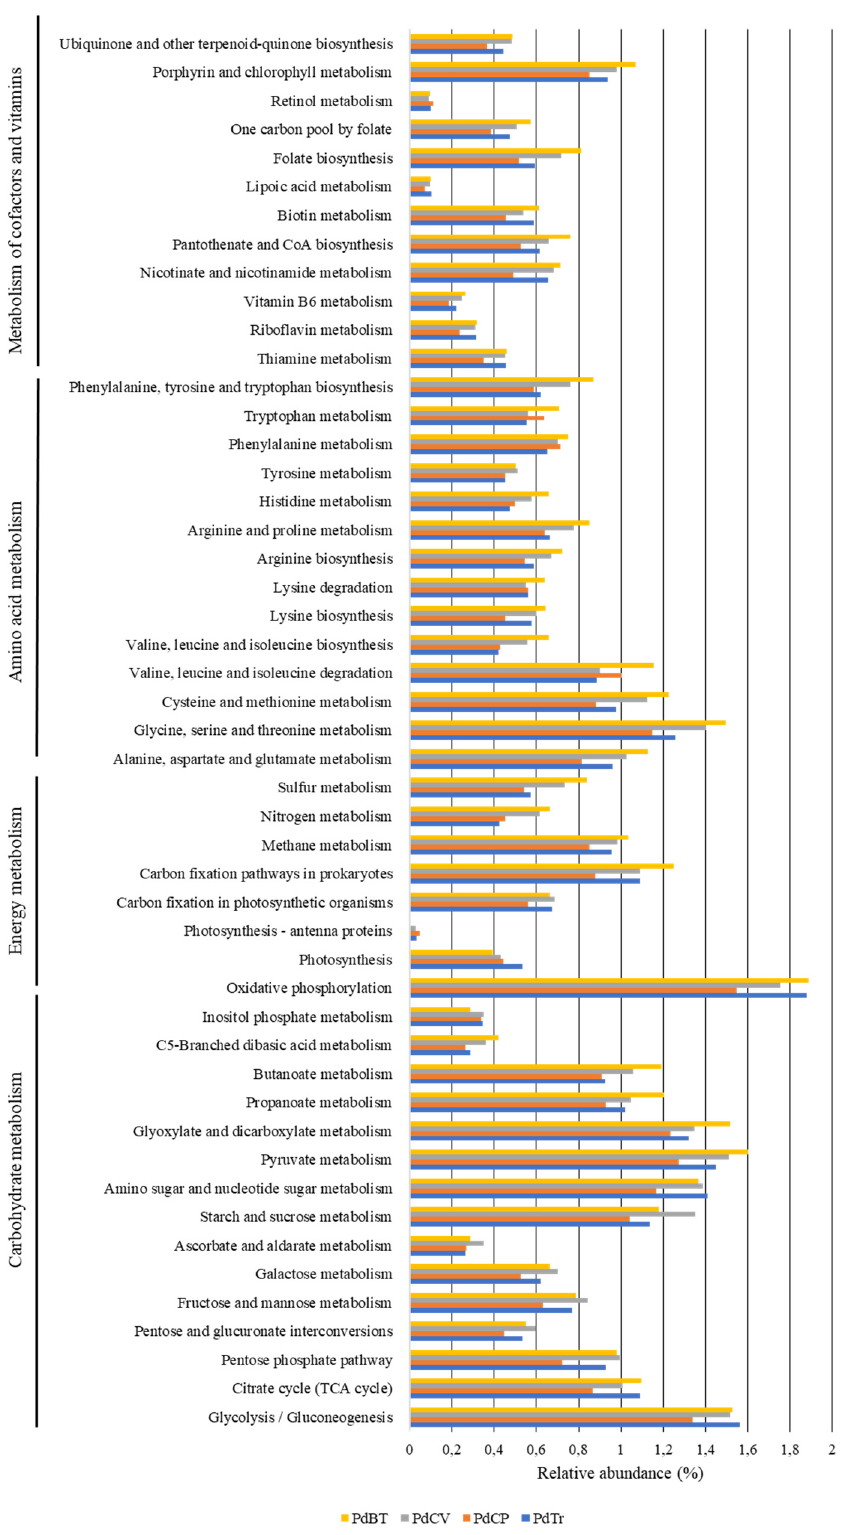
Figure 7. Relative abundance of KEGG pathways associated with carbohydrate metabolism, energy metabolism, amino acid metabolism, and metabolism of cofactors and vitamins in Porcellio dilata- tus bacterial communities. Porcellio dilatatus gut samples from Tronco (PdTr) (blue); Corte-Pinto (PdCP) (orange); Cabeço-de-Vide (PdCV) (grey) and Botanical Garden of University of Coimbra (PdBT)